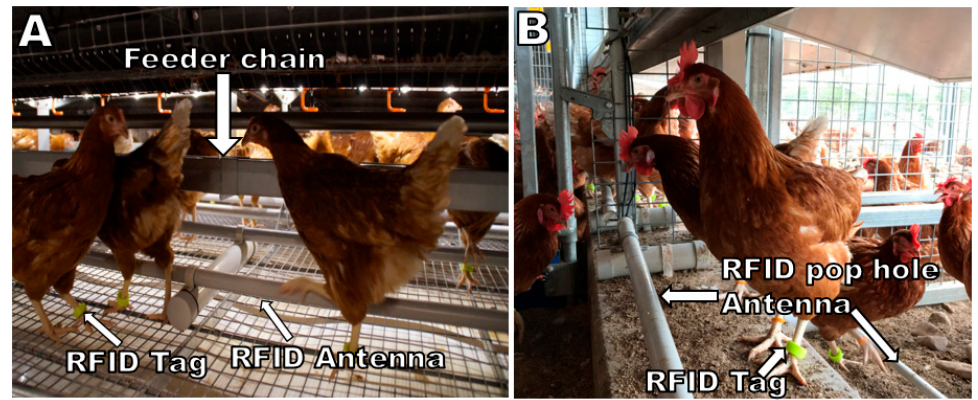
Figure 1. A picture showing the hens at the lower feeder tier ( A ) and the pop hole antenna ( B ). RFID = Radio-Frequency Identification.